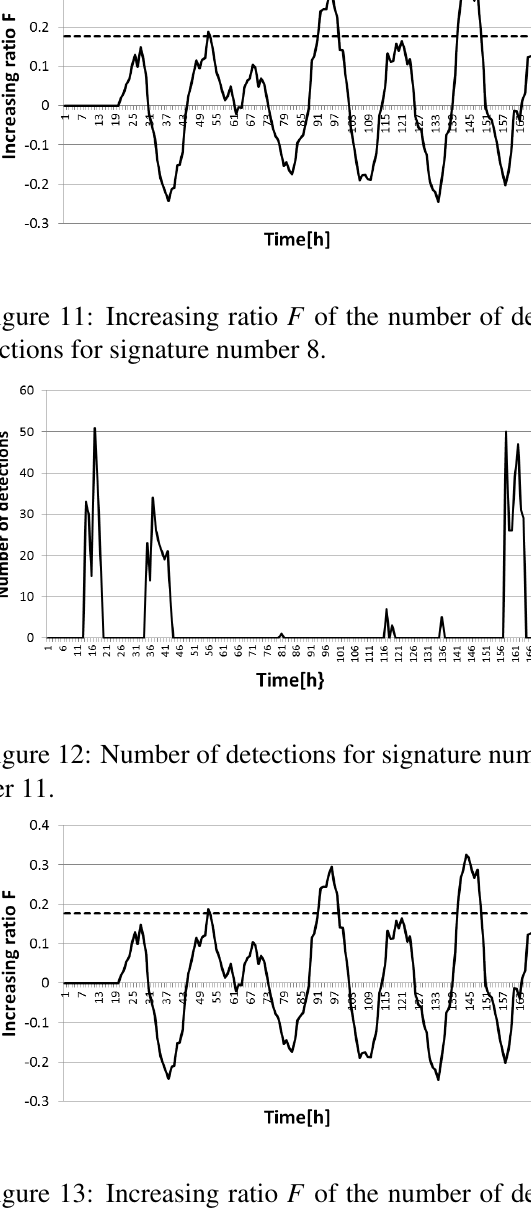
Figure 13: Increasing ratio F of the number of de- tections for signature number